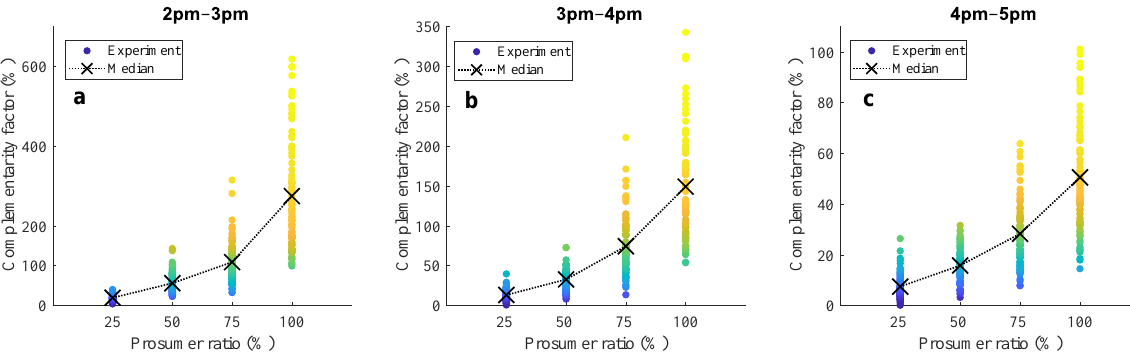
Figure 8. Comparison of complementarity factor (CF) for different of prosumers’ ratios (PR) in communities of N = 20 at ( a ) 2–3 p.m., ( b ) 3–4 p.m., and ( c ) 4–5 p.m.